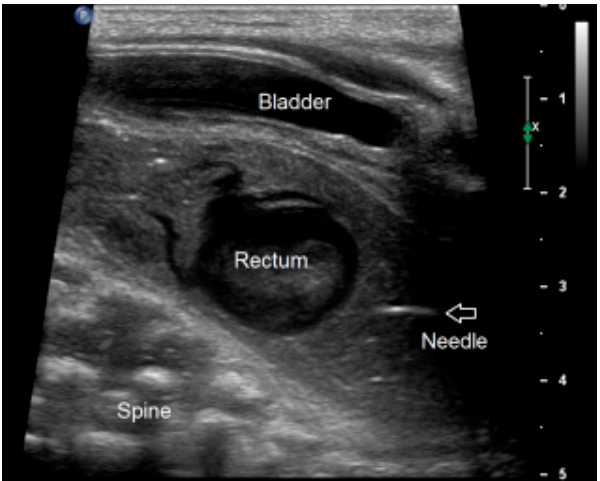
Figure 1. Ultrasound image during uPARP showing the guidance of the needle (arrow) towards the meconium-filled rectal pouch.